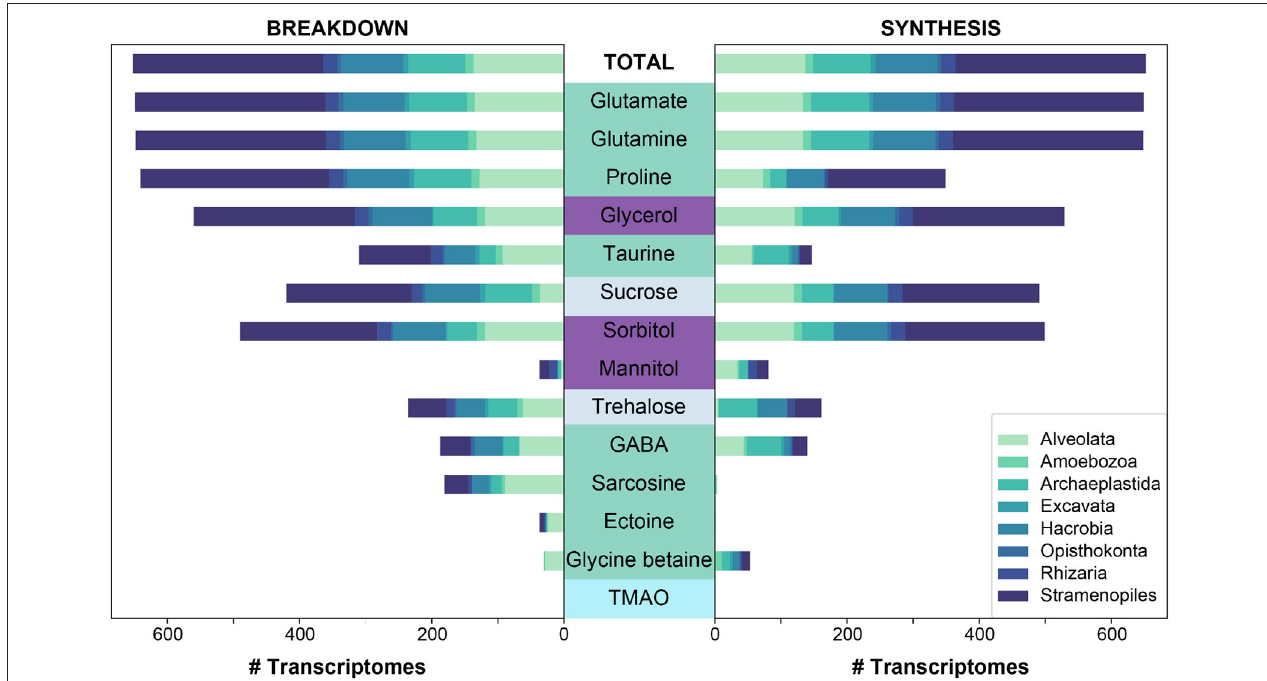
FIGURE 3 | The predicted synthesis and breakdown of targeted osmolytes across all (“Total”) MMETSP protist transcriptomes ( n = 652). The breakdown and synthesis of osmolytes is depicted as a stacked bar graph, and is colored by the designated taxonomic supergroup. Osmolytes are colored by higher classification: amino acids and derivatives in green, sugar alcohols in purple, sugars in light periwinkle, and an amine oxide in cyan. Osmolytes are sorted along the y-axis based on the total number of genomes capable of breaking down a given osmolyte for bacteria and archaea to be consistent with Figure 2